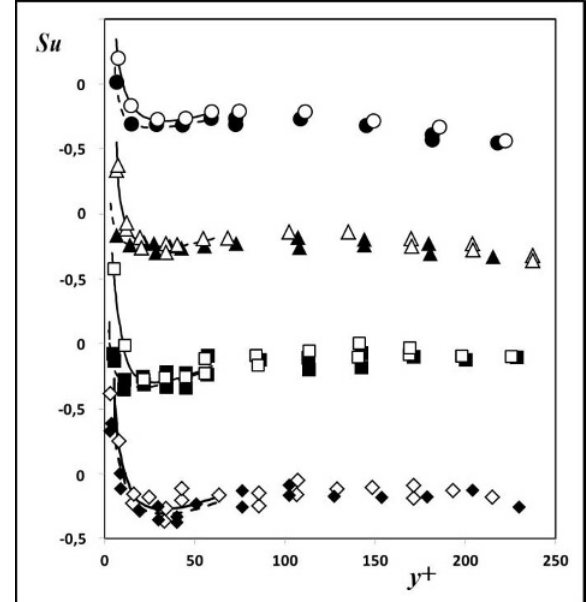
Fig. 8. Skewness factor profiles in the inner